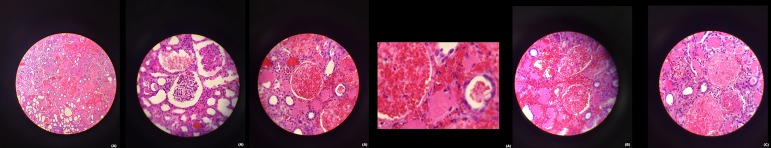
Renal Biopsy: extensive areas of ischemic and hemorrhagic infarction
(A), interstitial hemorrhage (B), and fibrin thrombi in medium-sized
vessels (C).